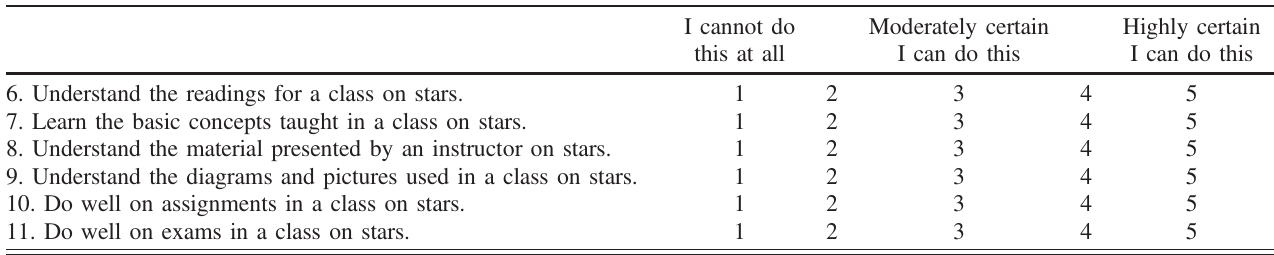
TABLE III. Self-efficacy instrument, administered as items 6 – 11 on the combined survey. [Instructions] Please rate how certain you are that you can perform the academic tasks listed below in a class on stars. Rate your degree of confidence by recording a number from 1 (Cannot do at all) to 5 (Highly certain can